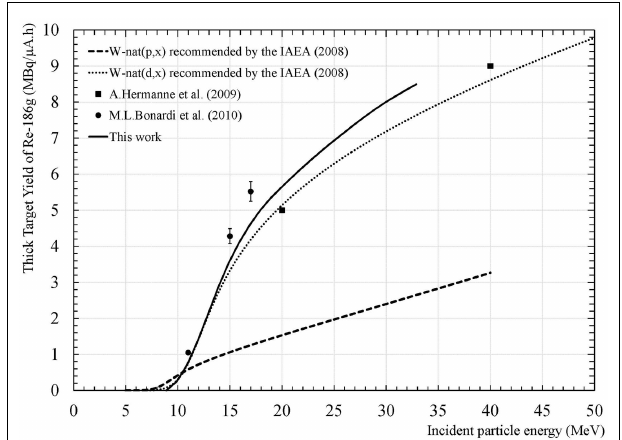
FIGURE 5 | Re-186g thick-target yield obtained from IAEA (20) data with proton and deuteron and value determined from new experimental data from Duchemin et al. (18) . Symbols correspond to values extracted from Hermann et al. (21) and Bonardi et al.